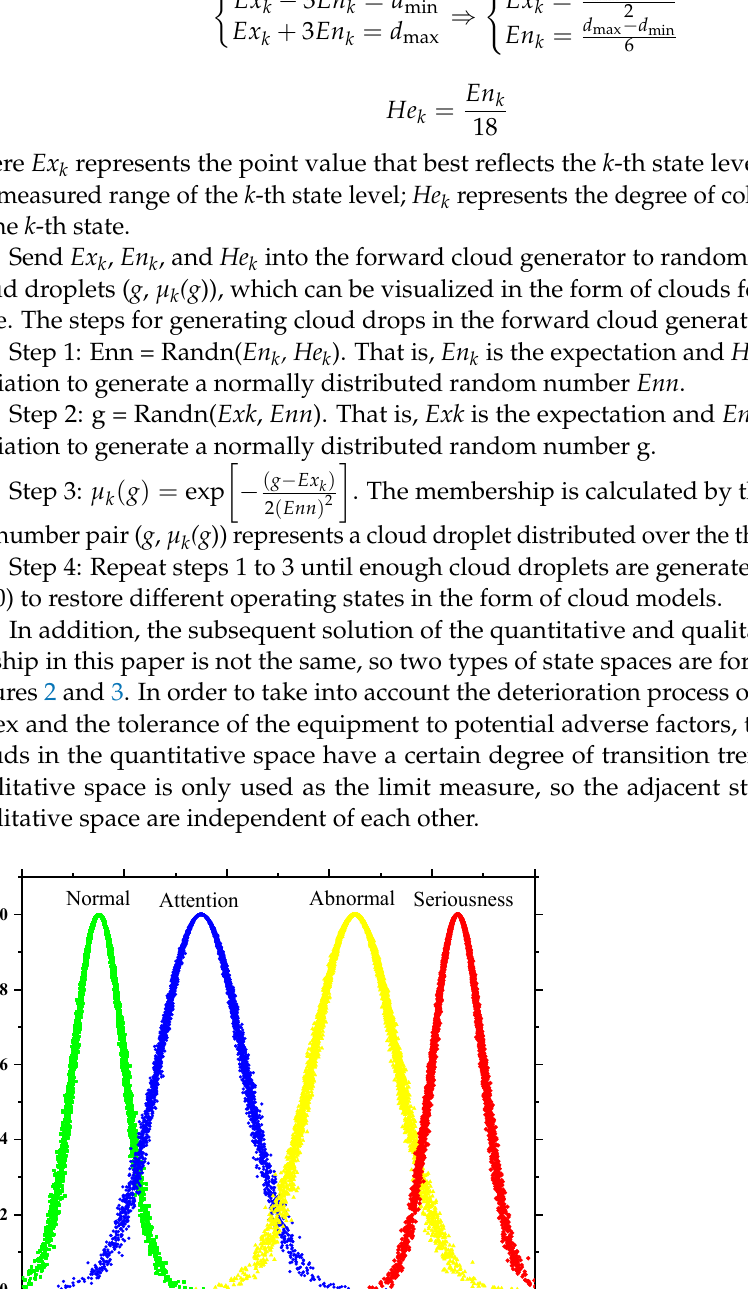
Figure 3. State space of qualitative indicator. 4.3. Quantitative Indicators In this paper, before determining the membership degree of quantitative indicators, the degradation degree function is introduced in order to normalize them and transform them uniformly to the range of [0, 1]. The quantitative indicators within the evaluation system can be divided into three categories: cost type